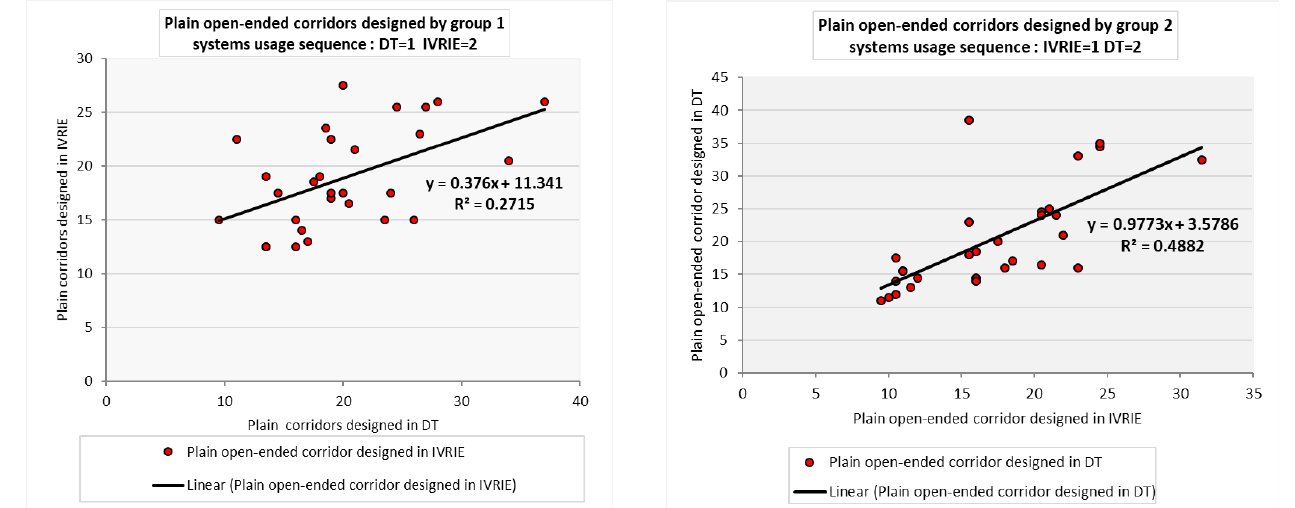
Figure 12. Linear regression trends for plain, open-ended corridors designed in IVRIE and the DT system by both groups of participants. system by both groups of